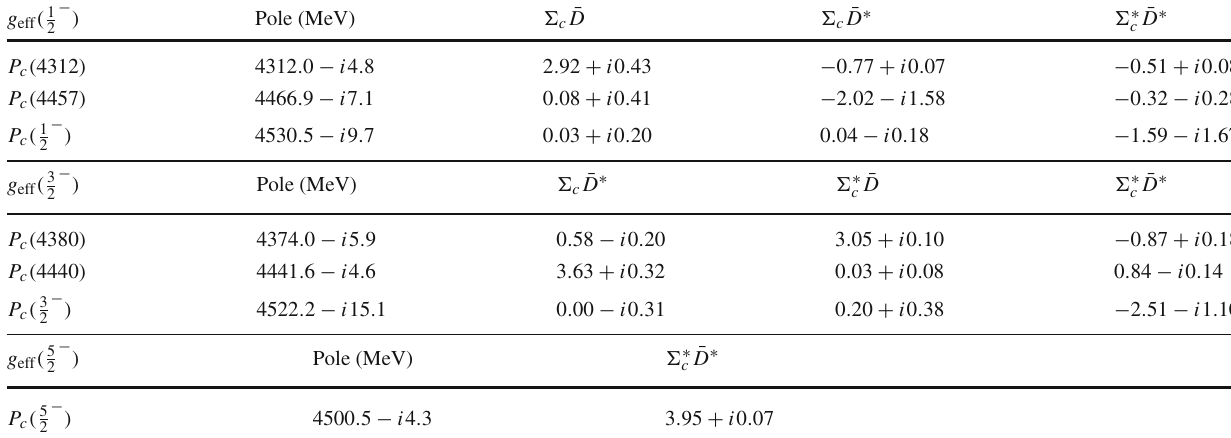
− − − , three 3 and one 5 pentaquarks in Solution A with hard cutoff 1 GeV. The 2 2 2